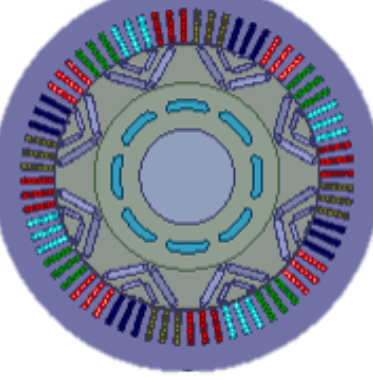
Figure 8. Finite element model